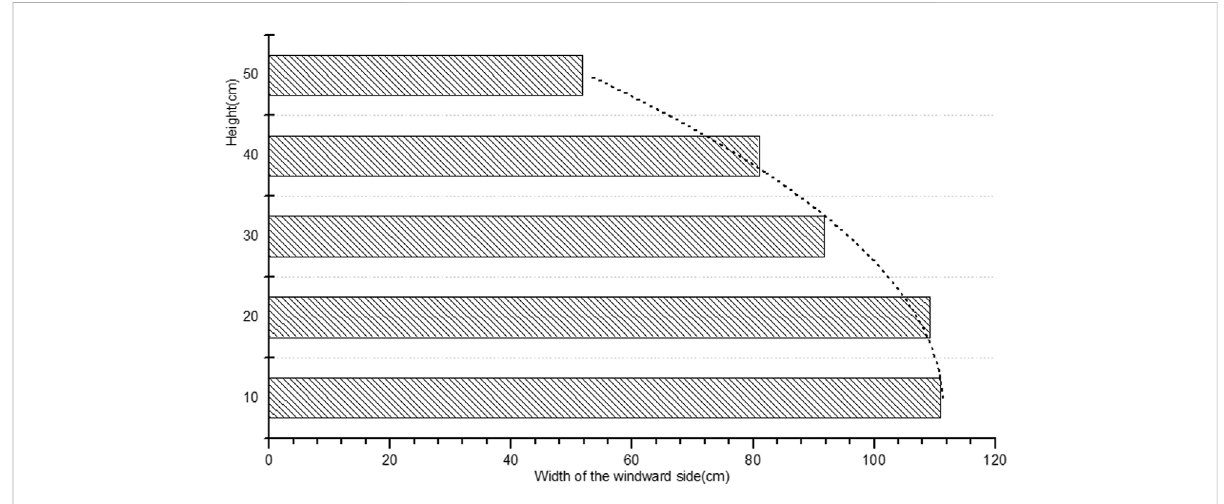
FIGURE 3 The width of Artemisia ordosica on the windward side at different heights.